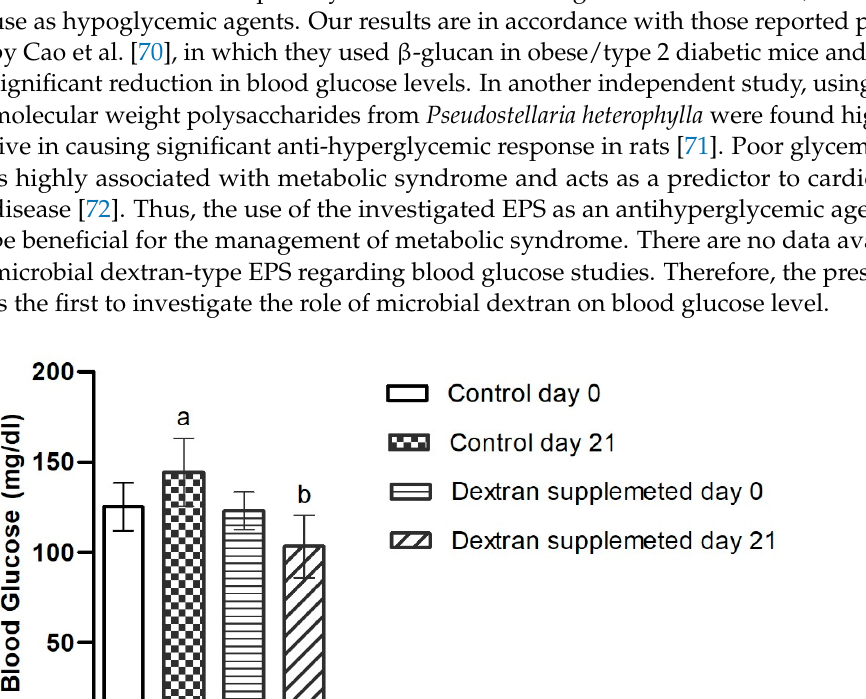
Figure 7. Average body weight gain in control and Apilactobacillus waqarii EPS supplemented group in comparison of day 0 and 21. The values of data sets ( n = 6) denoted by different alphabet are significantly different ( p < 0.05).